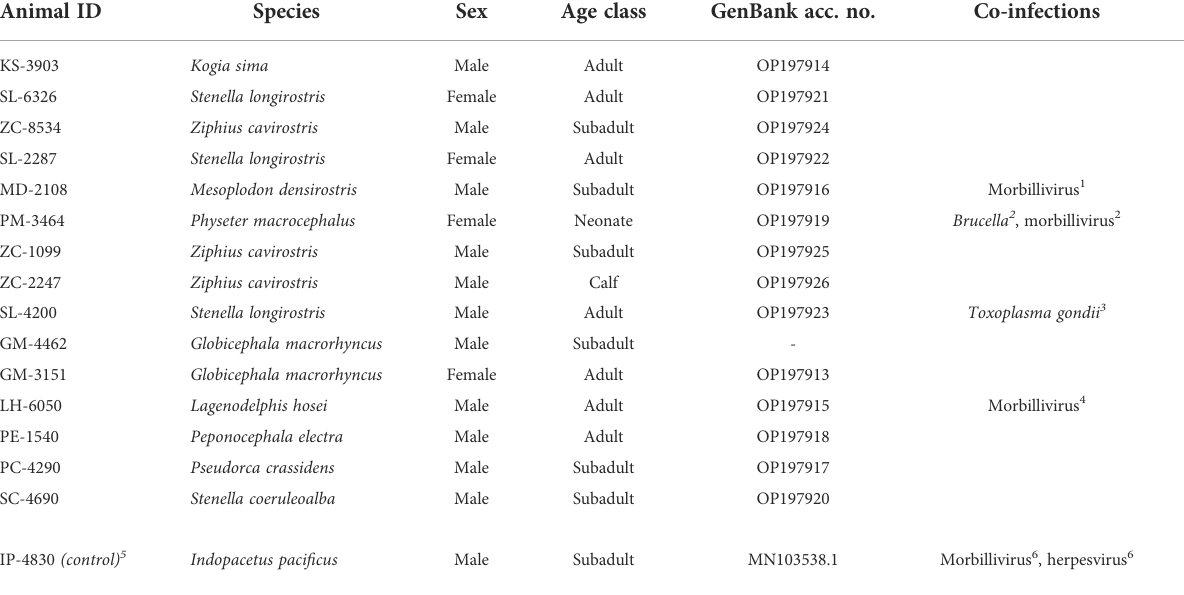
TABLE 2 Animal cases that tested positive for beaked whale circovirus, their demographics, and detected presence of other infections. Animal